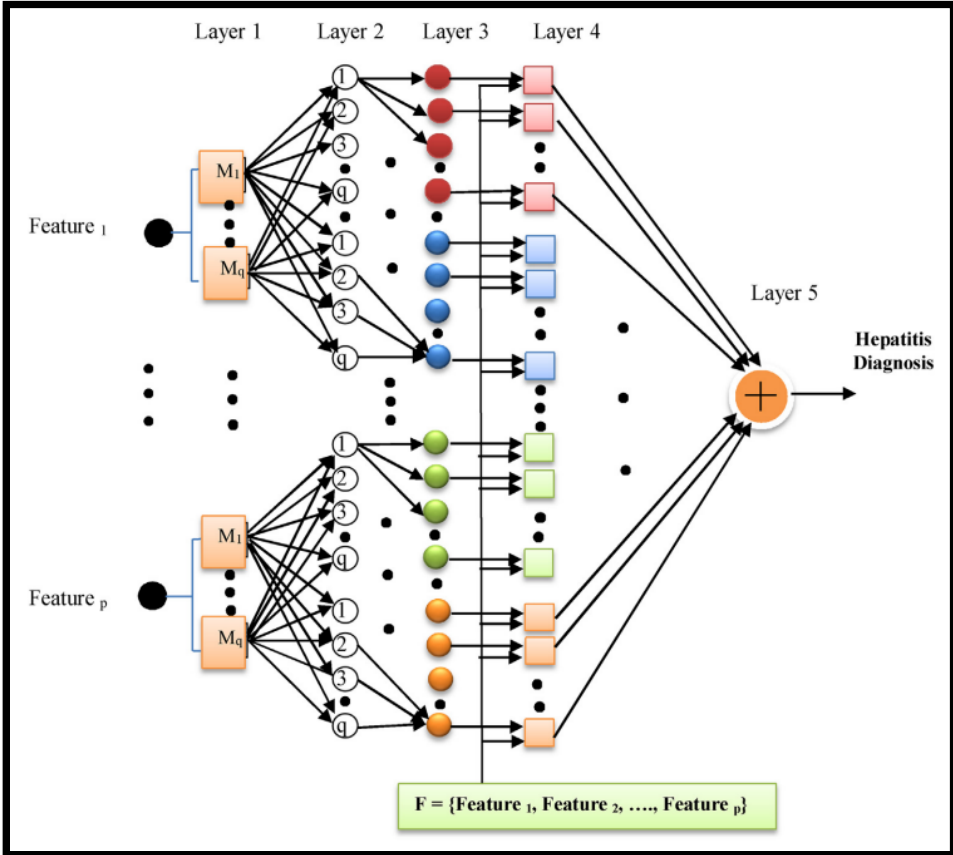
Figure 4. ANFIS model for hepatitis diagnosis.